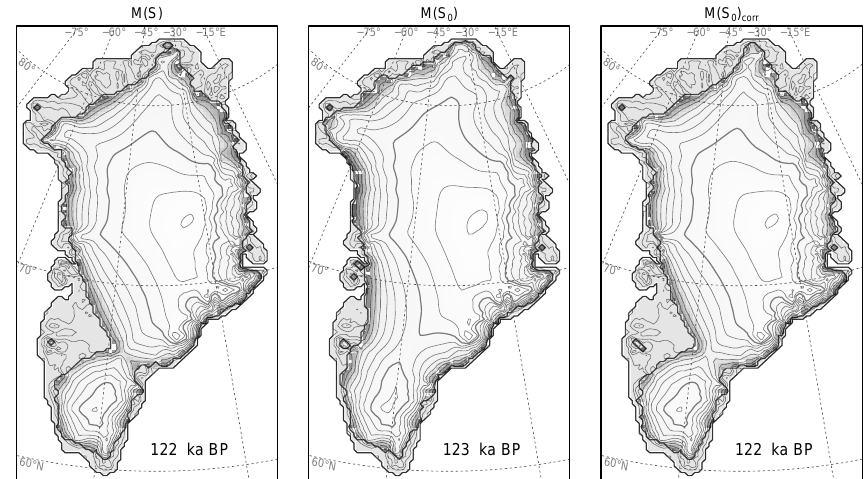
Figure 8. Distribution and timing of the minimum ice sheet volume during the Eemian for coupled simulations using the full model (left), the reduced model (middle) and the insolation-corrected model